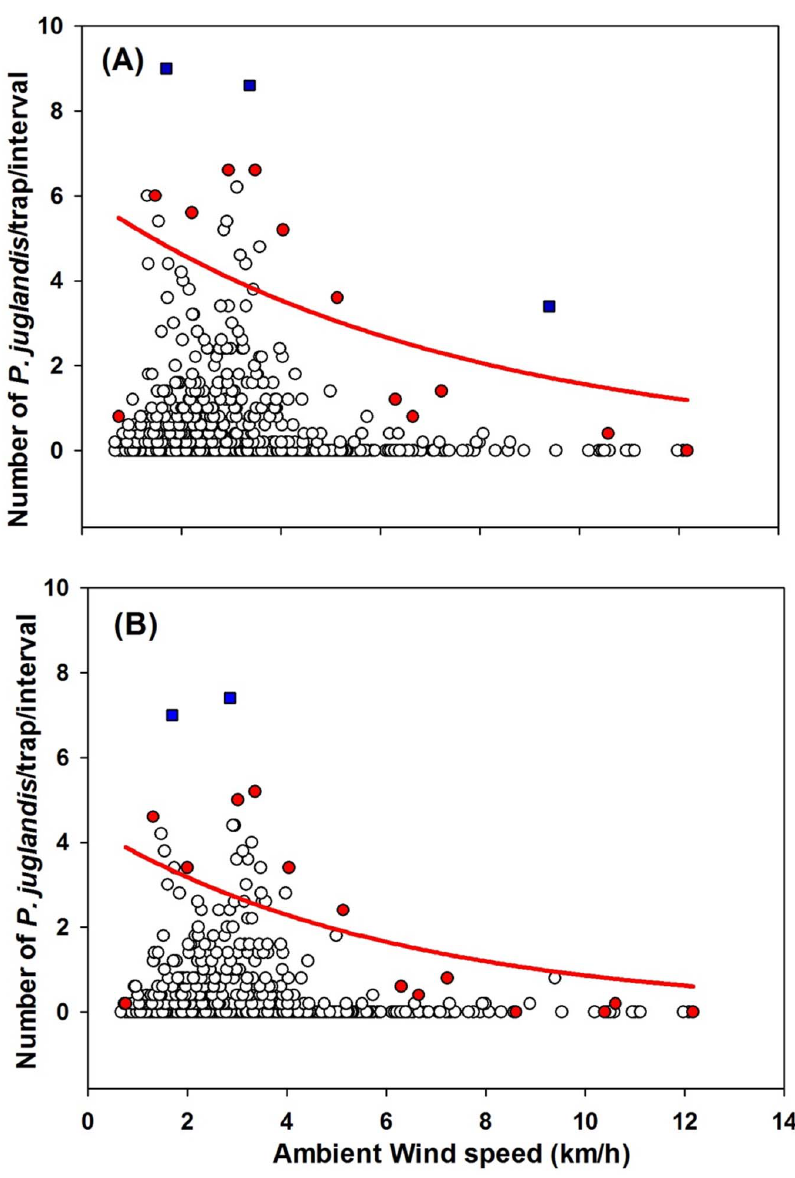
Figure 6. The exponential decay relationship ( Y = a 6 exp ( 2 bX )) between Pityophthorusjuglandis catches and wind speed (km/h). (A) Female: N =1205, F =5.64, P , 0.05, a =6.06, b =0.13, adj. R 2 =0.30; (B) Male: N =1205, F =7.39, P , 0.05, a =4.40, b =0.16, adj. R 2 =0.33. Blue % : Outliers; Red q : Data points used to fit curves. These points were the greatest values of trap catches from each of the wind speed classes [28].